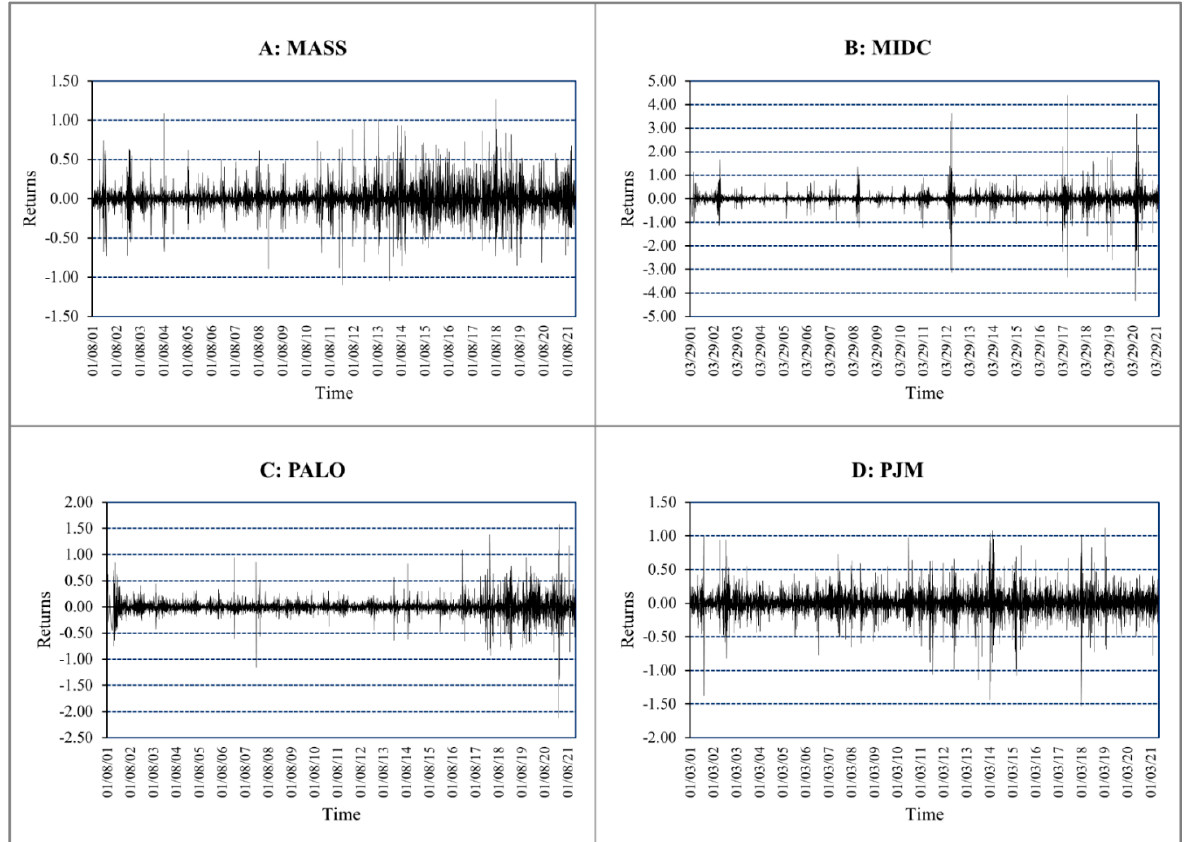
Figure 1. Daily fluctuations in log returns of electricity indices. Table 2. Descriptive statistics.